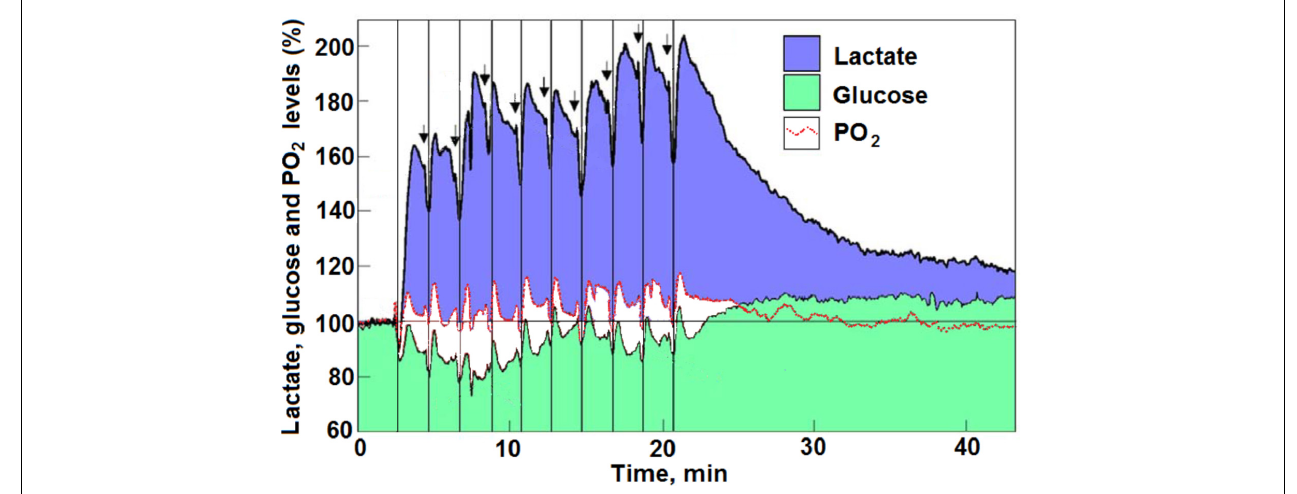
FIGURE 3 | Profiles of time course and dynamic relationships of local extracellular lactate, glucose, and PO 2 levels in the rat hippocampal dentate gyrus during a series of 5 s electrical stimulations (arrows) of the perforant pathway at 2 min rest intervals (reproduced with permission from Hu and Wilson, 1997 copyright, Blackwell, Oxford). The changes in the mean concentration of glucose were always in opposite direction to the changes in mean lactate concentration. The vertical lines were drawn to indicate the simultaneous dip in all three analytes in response to each of the electrical stimulations. For additional details see Hu and Wilson (1997) and Schurr and Gozal (2011) from where the figure and the legend have been reproduced with permission.